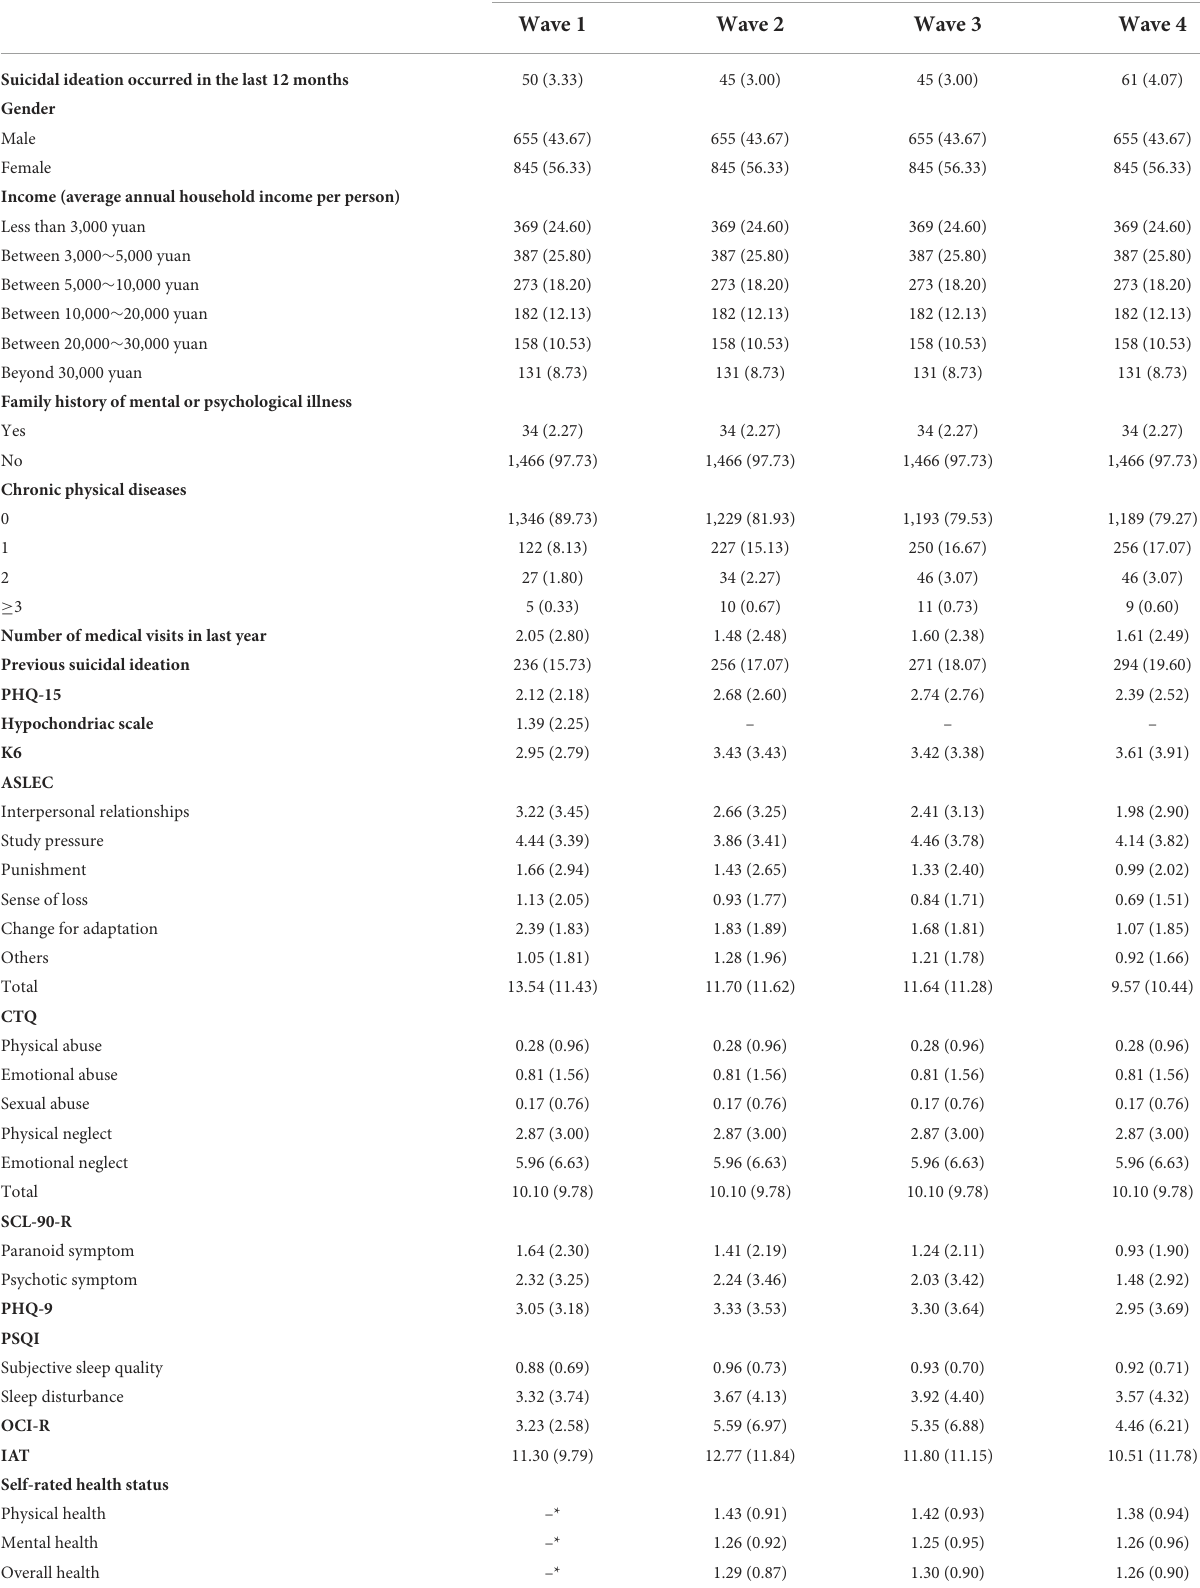
TABLE 2 Distribution of main variables through wave one to wave